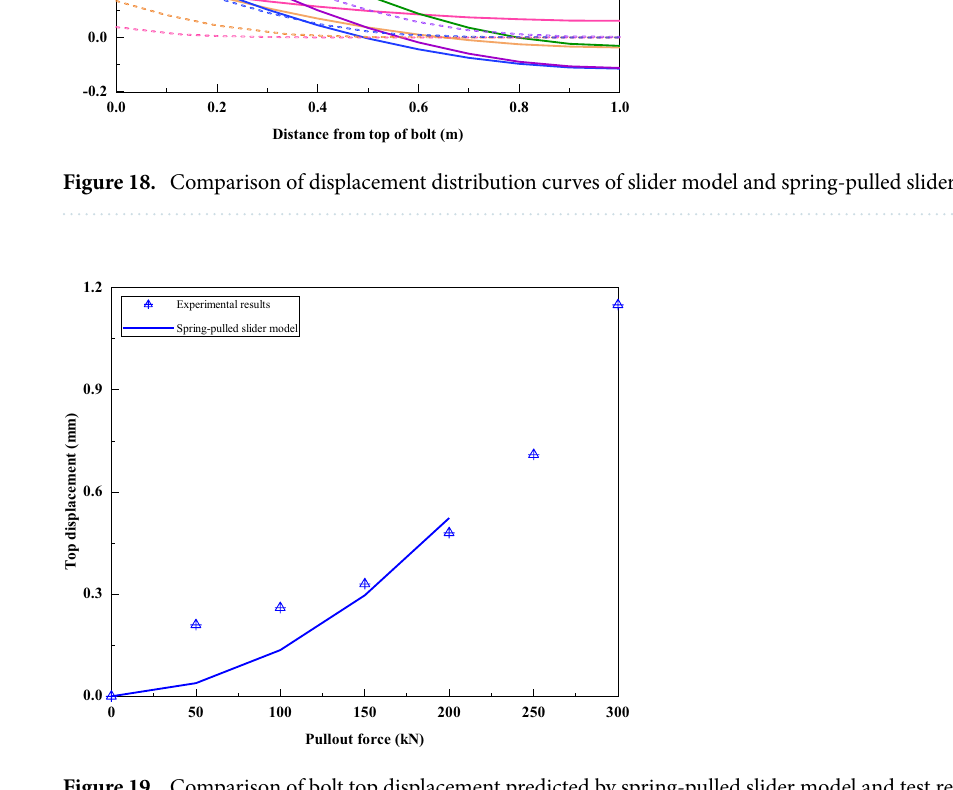
Figure 19. Comparison of bolt top displacement predicted by spring-pulled slider model and test